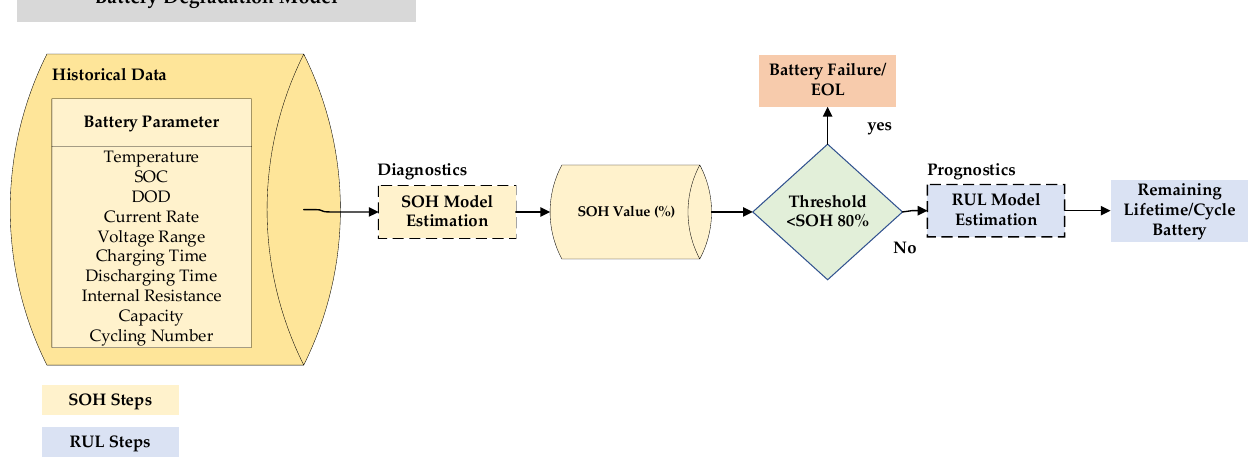
Figure 8. Relationship battery degradation models.